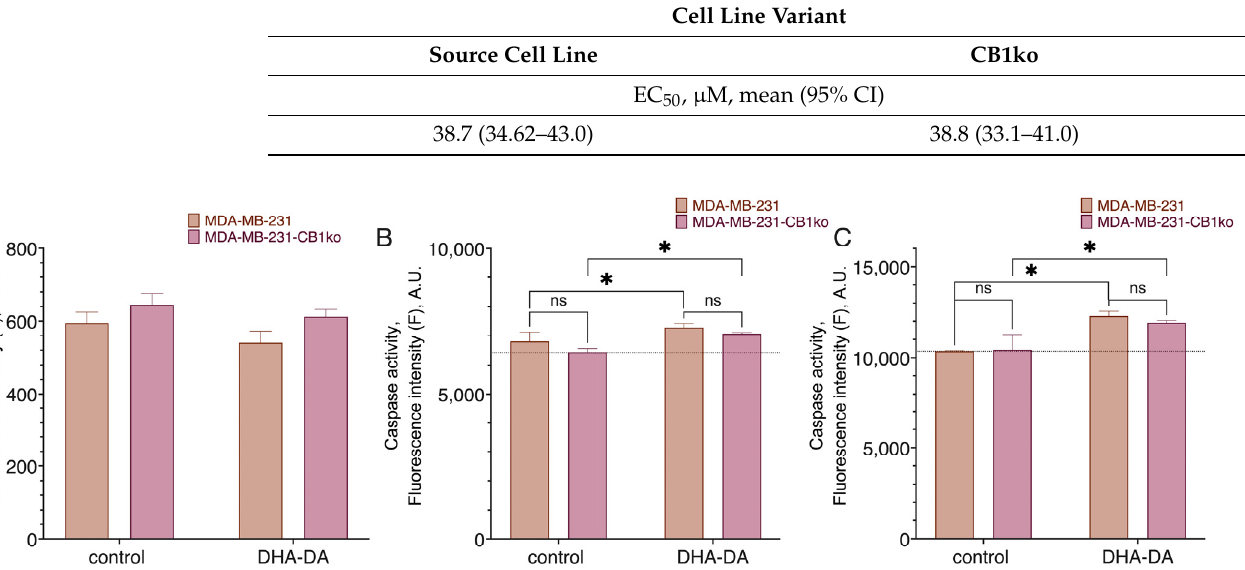
Figure 2. Effect of DHA ‐ DA (40 μ M) on the caspase activation in the MDA ‐ MB ‐ 231 cell line after CB1 receptor knockout. A total of 3 h incubation time: fluorogenic substrate measurement data. ( A ) caspase 8, ( B ) caspase 9, ( C ) caspase 3; *, a statistically significant difference from the control without substance in the ANOVA test with the Holm–Sidak post ‐ test; ns, not significant.